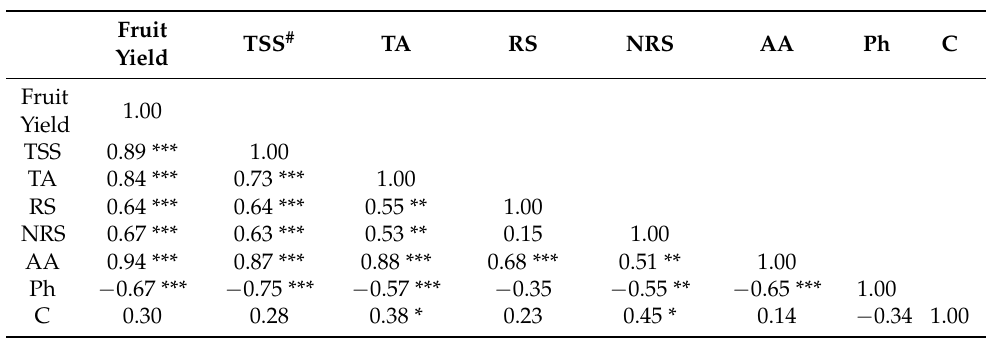
Table 5. Relationship between yield and quality parameters of tomato under elevated CO 2 , temperature and their